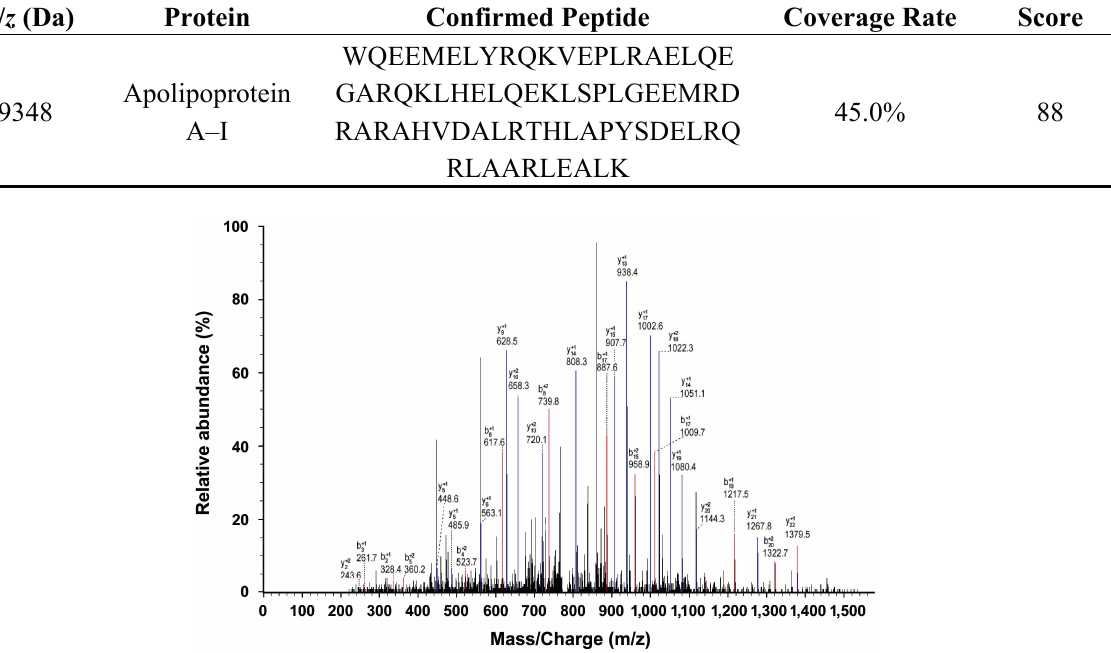
Figure 5. 2D-LC-LTQ-MS analysis of peptide segments obtained by enzymatic hydrolysis of the proteins or peptide segments with an m / z of 9348